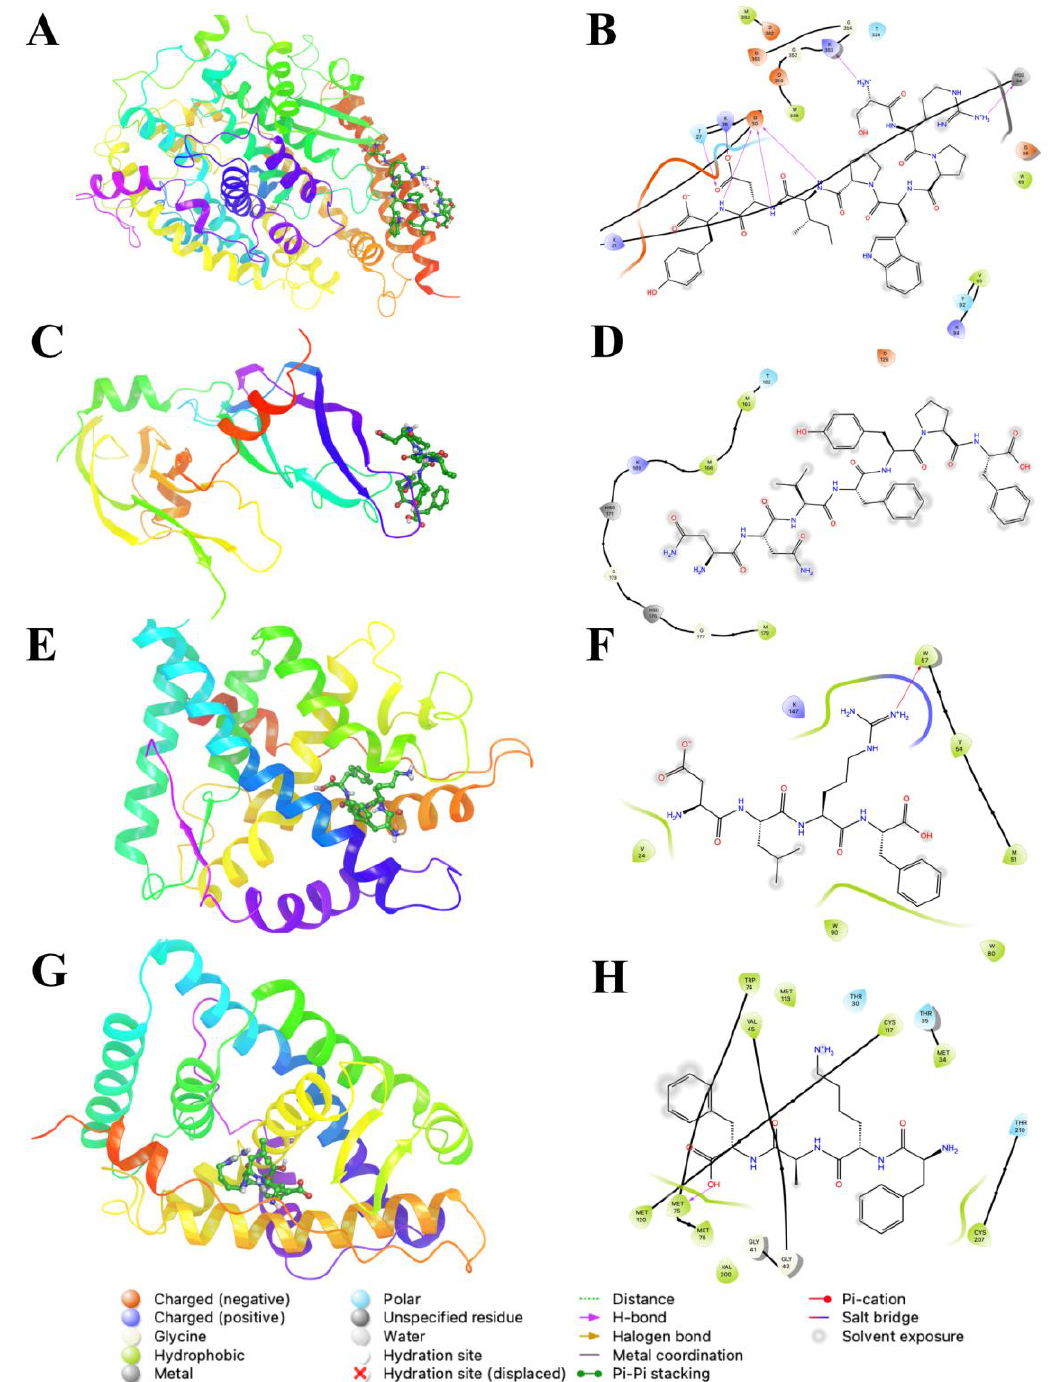
Figure 3. Binding modes (left) and ligand interaction diagrams (right) of selected peptides from library vs. selected molecular targets. ( A , B ): Angiotensin converting enzyme (ACE) in complex with WPRSPIDY; ( C , D ): Vascular Endothelial growth factor (VEGF) in complex with FVNYPF; ( E , F ): Glucocorticoid receptor (GLUC) in complex wit KFAF; ( G , H ): Mineralocorticoid receptor (MINC) in complex with RLDF. Ligand interactions were calculated around a 5 Å distance